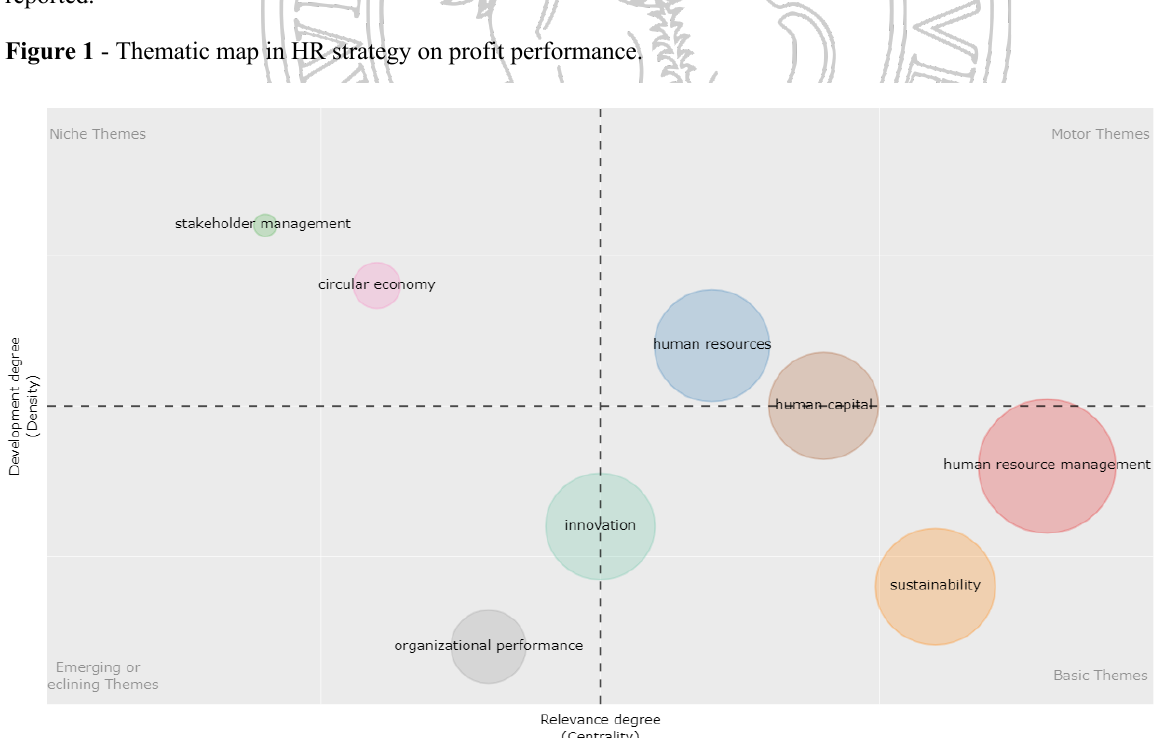
Figure 1 - Thematic map in HR strategy on profit